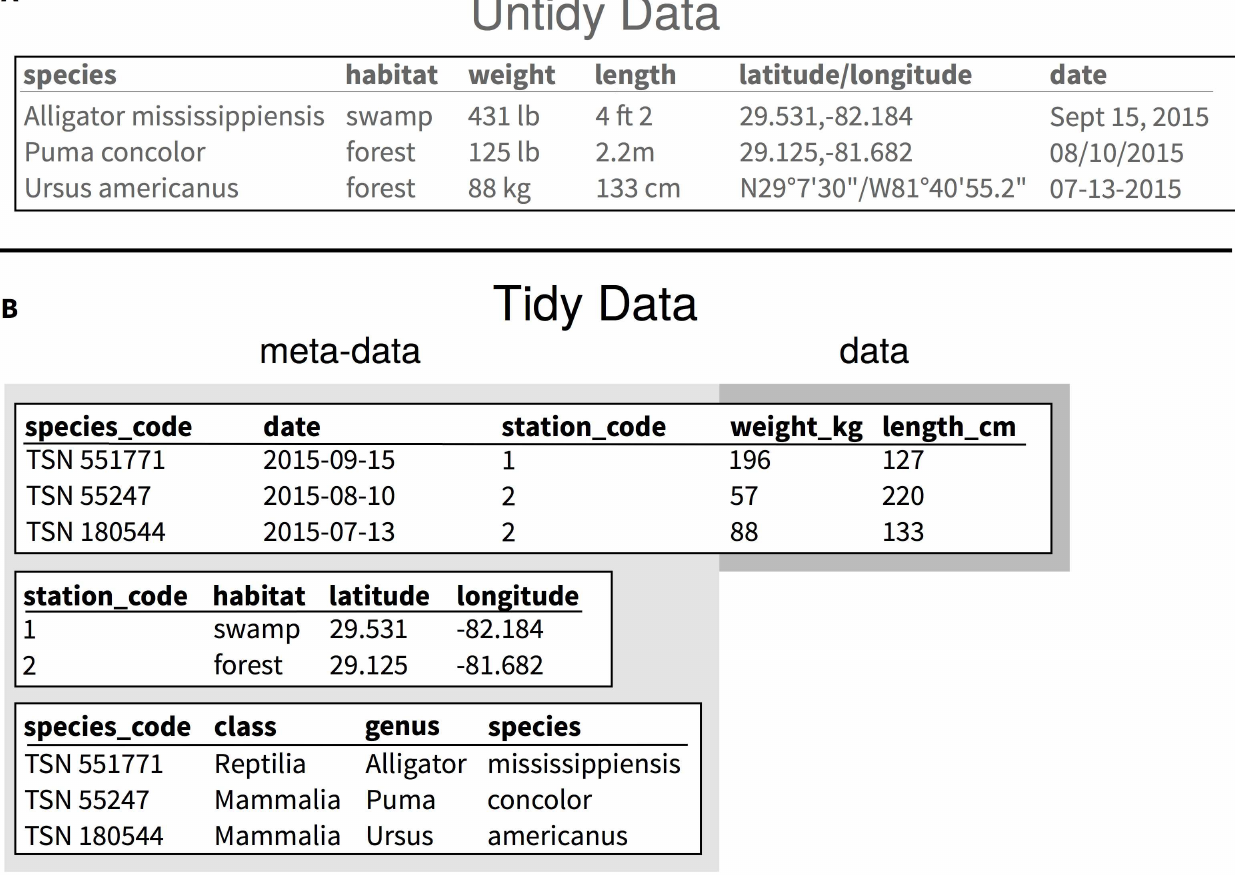
Fig 1. Example of an untidy dataset (A) and its tidy equivalent (B). Dataset A is untidy because it mixes observational units (species, location of observations, measurements about individuals), the units are mixed and listed with the observations, more than one variableis listed (both latitude and longitudefor the coordinates, and genus and species for the species names), and several formats are used in the same column for dates and geographic coordinates. Dataset B is an example of a tidy version of dataset A that reduces the amount of information that is duplicated in each row, limiting chances of introducingmistakes in the data. By having species in a separate table, they can be identifieduniquelyusing the Taxonomic Serial Number (TSN) from the Integrated Taxonomic Information System (ITIS), and it makes it easy to add informationabout the classification of these species. It also allows researchers to edit the taxonomic information independently from the table that holds the measurements about the individuals. Unique values for each observational unit facilitate the programmatic combination of informationusing “join” operations. With this example, if the focus of the study for which these data were collected is based upon the size measurements of the individuals (weight and length), information about “where,” “when,” and “what” animals were measured can be consideredmetadata. Using the tidy format makes this distinction